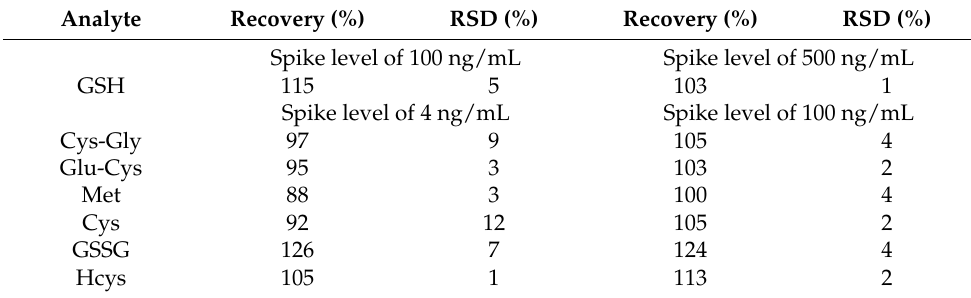
Figure 2. Extracted ion chromatograms of the standard mixture prepared at 200 ng/mL (left) and a representative sample (right). * The peak at 5.41 min in the Cys-Gly panel (grey) was contributed by GSH. Table 2. Spike recovery and relative standard deviation (RSD, n =